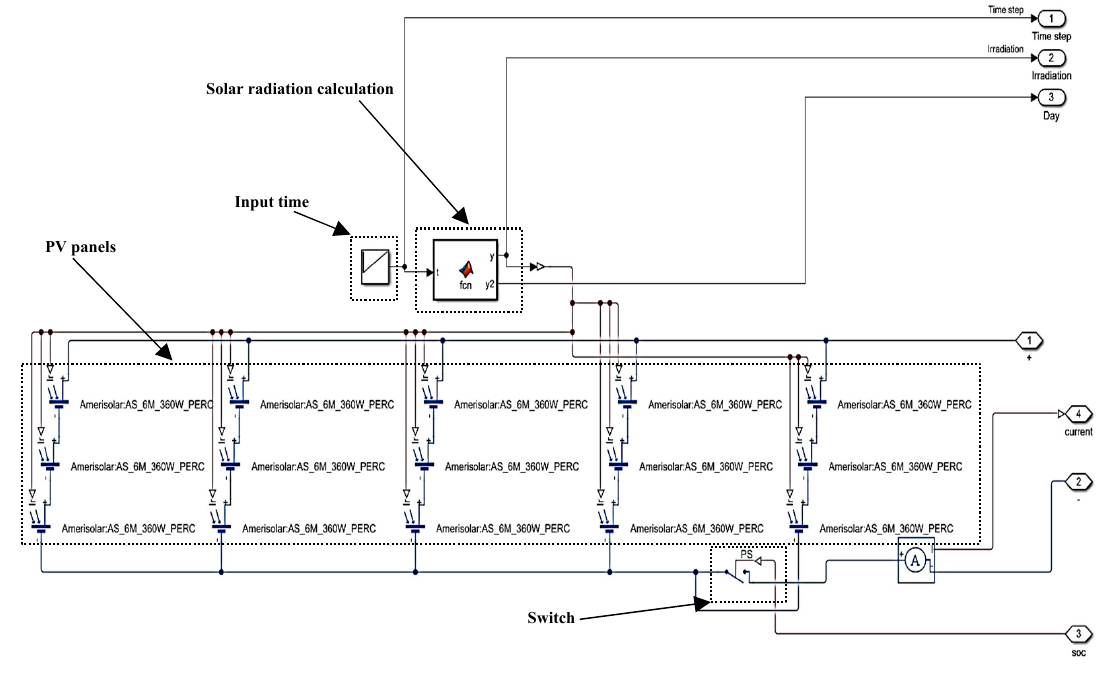
Figure 3. Block diagram of the solar PV system in MATLAB